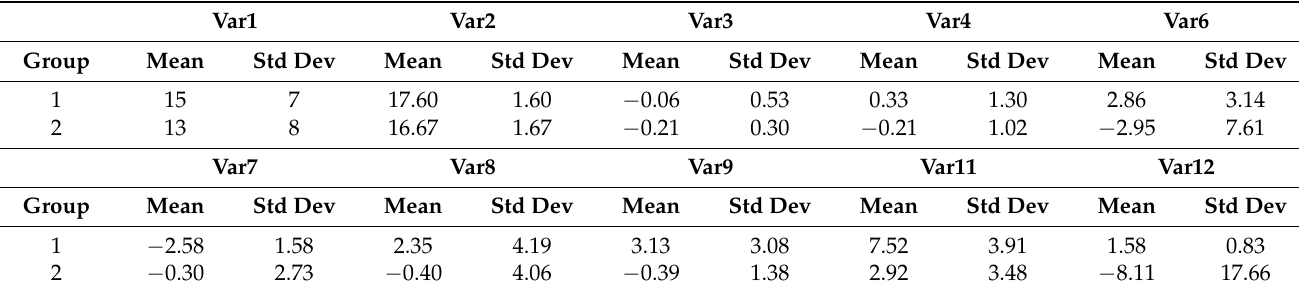
Table 5. Mean and standard deviation of variables in each